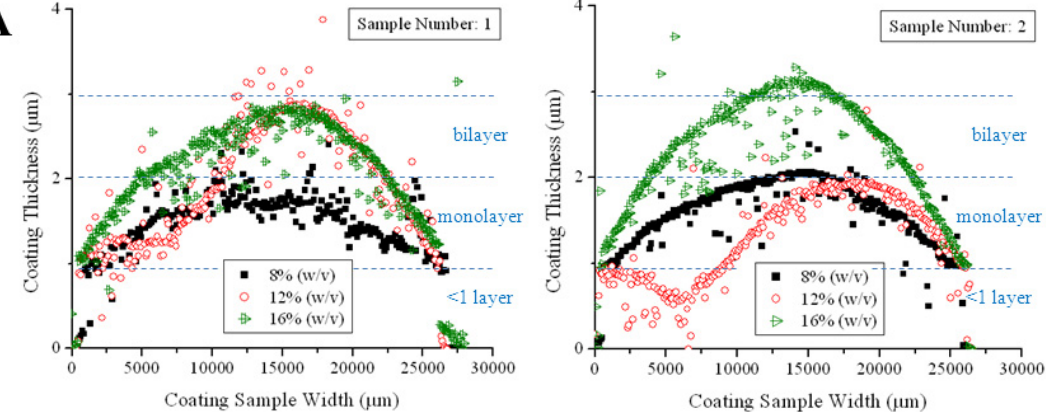
Figure 6. Effect of suspended particle concentration on coating ( A ) thickness and ( B ) void space for regions of coatings deposited from 8%, 12%, and 16% suspensions of 1.0 µm sulfated polystyrene polymer particles. Thickness profiles determined by profilometry are grouped by sample number to simplify data interpretation. ( C ) Coating deposited at 16% solids showing minimized particle aggregation along coating edges. Arrow indicates direction of deposition; scale bar is 5.0